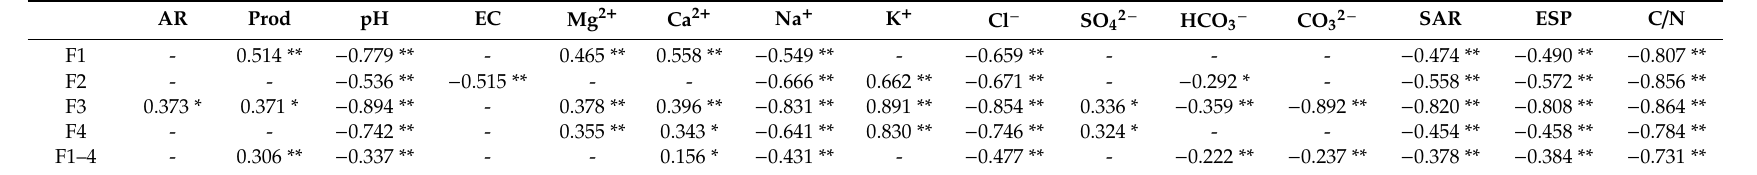
Table 9. Pearson’s correlation coe ffi cient among nitrogen, application rate, corn production, and soil chemical properties.